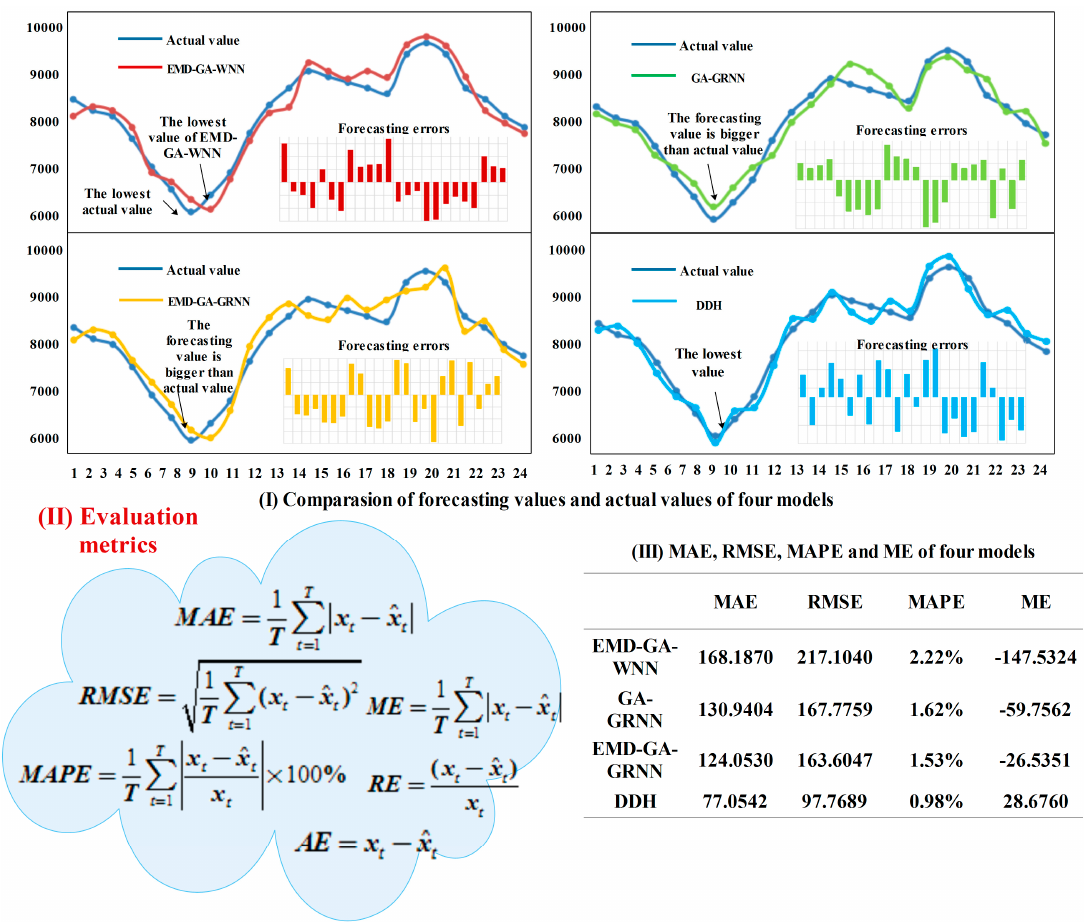
Figure 7. Forecasting results of each model.